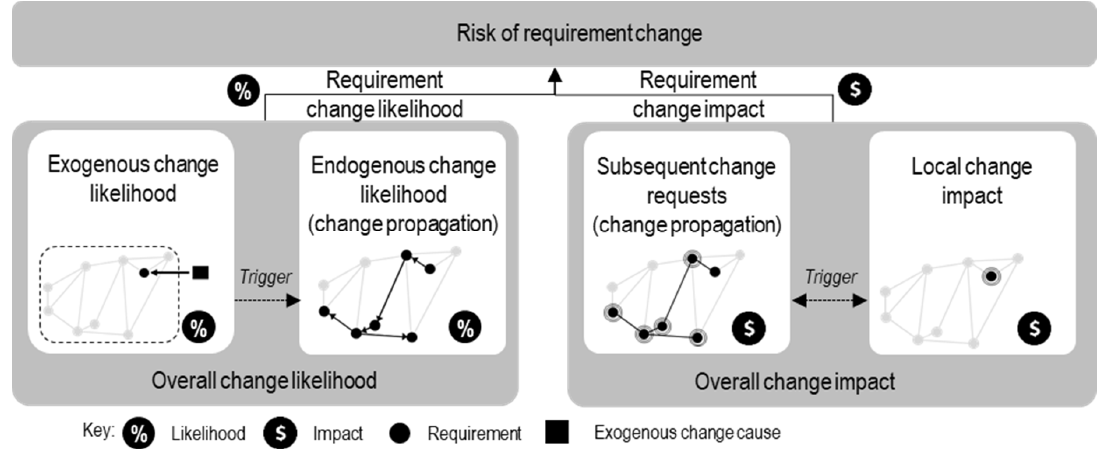
Figure 4. Conceptual model of requirement change risk factors .